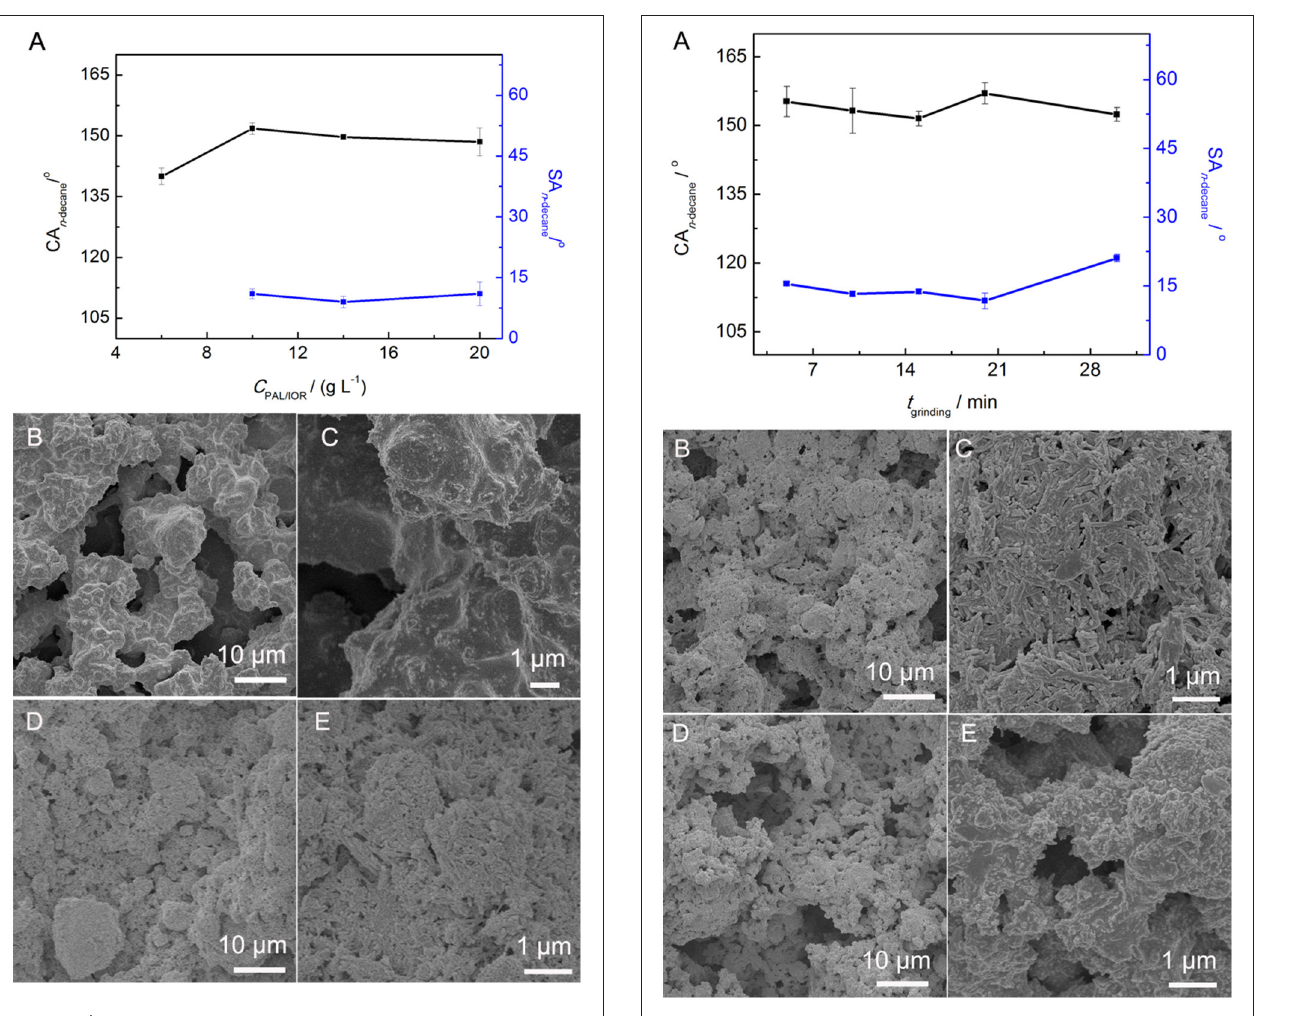
FIGURE 5 | (A) Variation of CA n − decane and SA n − decane of the PAL/IOR@fluoroPOS coatings with t grinding . SEM images of the coatings with a t grinding of (B,C) 5min and (D,E) 30min. C PAL / IOR = 14g L − 1 , C PFDTES = 27.2mM, C TEOS =